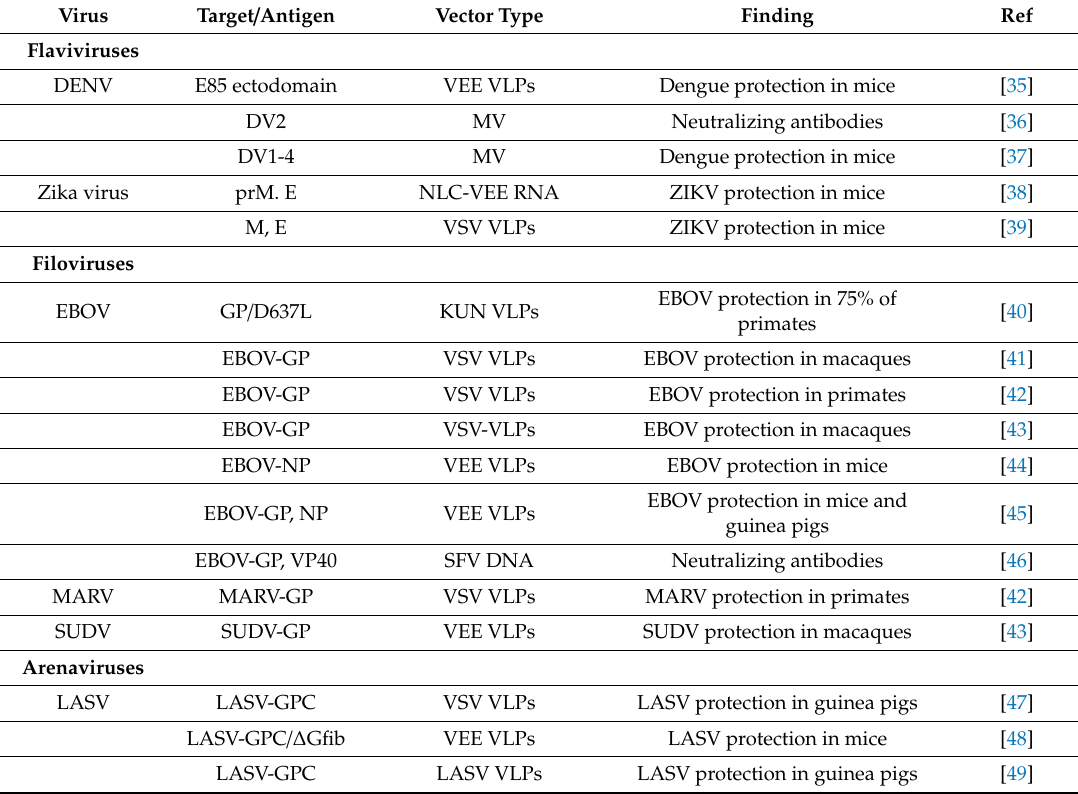
Table 1. Examples of preclinical immunizations against viral